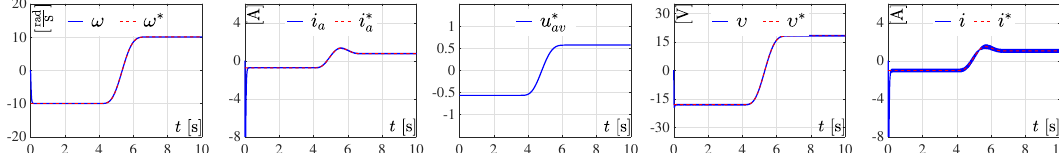
Figure 5. Circuit simulation results for a Bézier polynomial-type trajectory. The results related to the mathematical model are denoted by ω , i a , υ , i , and the results associated with the reference variables are labeled as ω ∗ , i ∗ a , u ∗ av , υ ∗ , i ∗ .